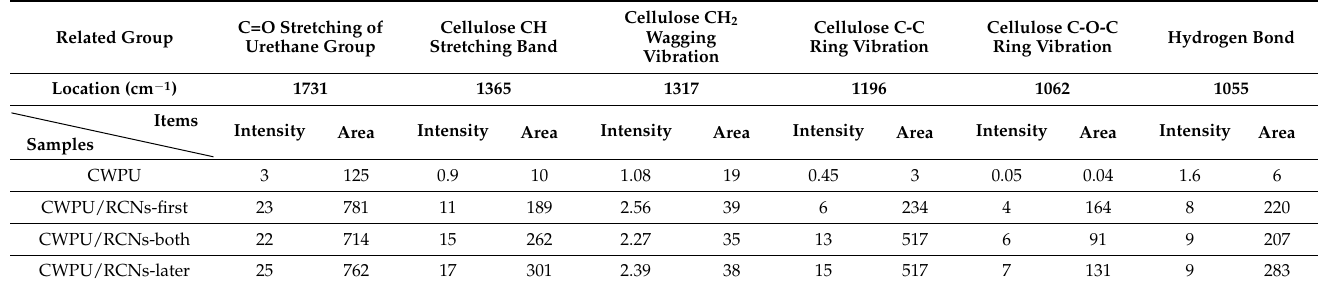
Table 2. Curve-fitting results of FTIR peak assignments for CWPU and CWPU/RCNs dispersions according to the step of adding RCNs in Figure 3c.